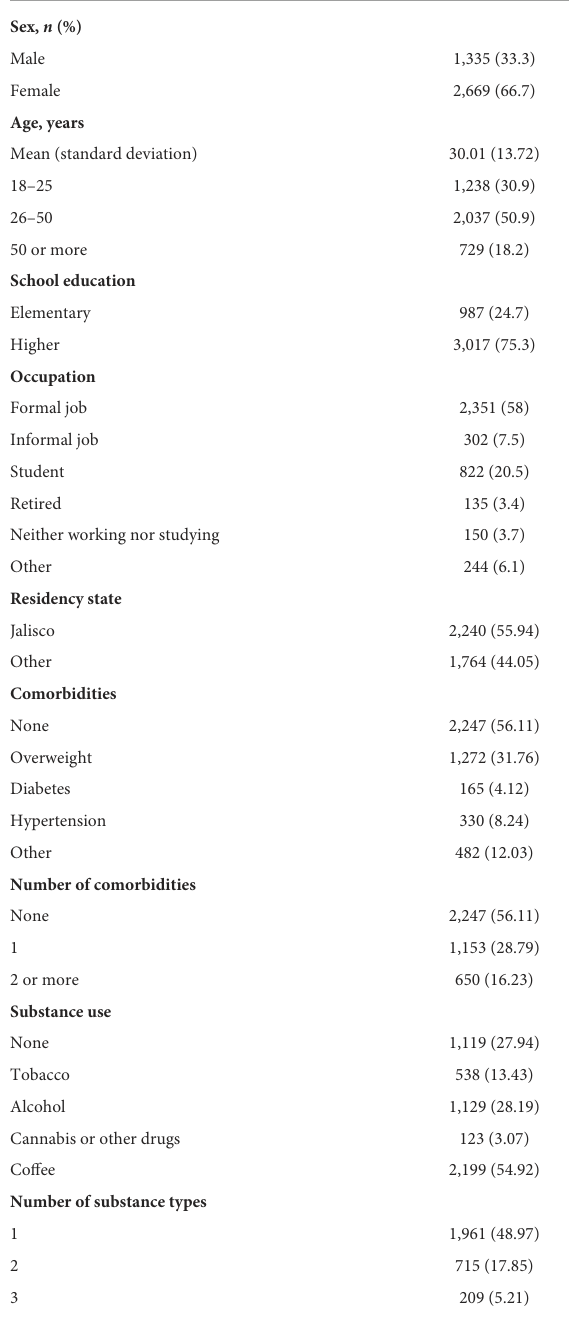
TABLE 1 Participant demographic